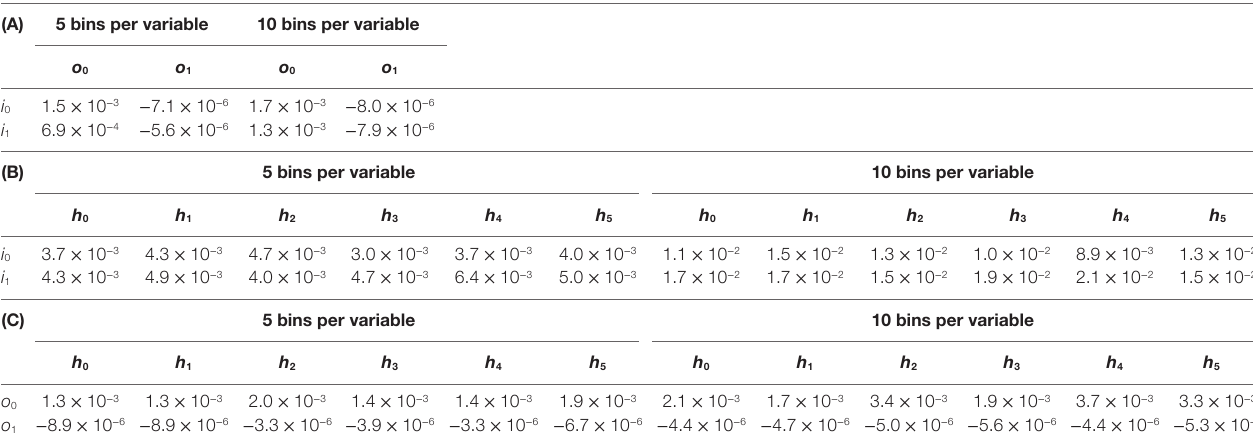
TaBle 1 | Mutual information between the states of nodes of the ann of T_9_9. (a) 5 bins per variable